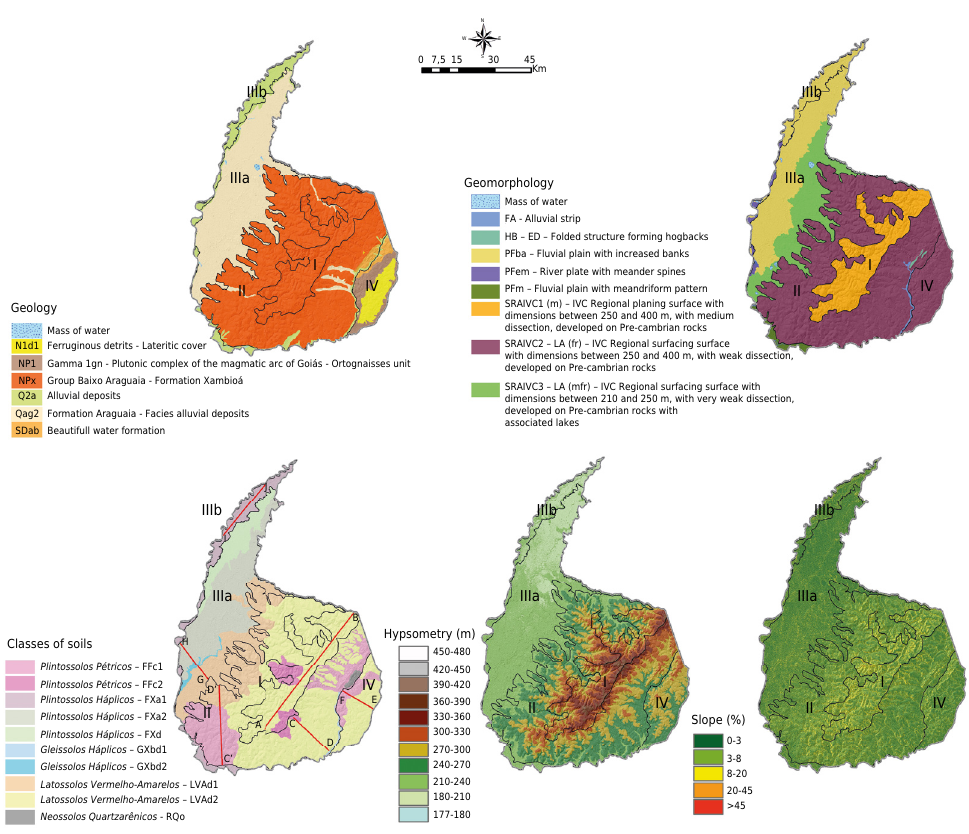
Figure 4. Physiographic maps (geology, geomorphology, soils, hypsometry, and slope) of the municipality of São Miguel do Araguaia, Goiás,